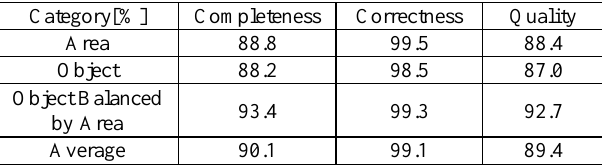
Table 1. Overall performance of building rooftop modelling